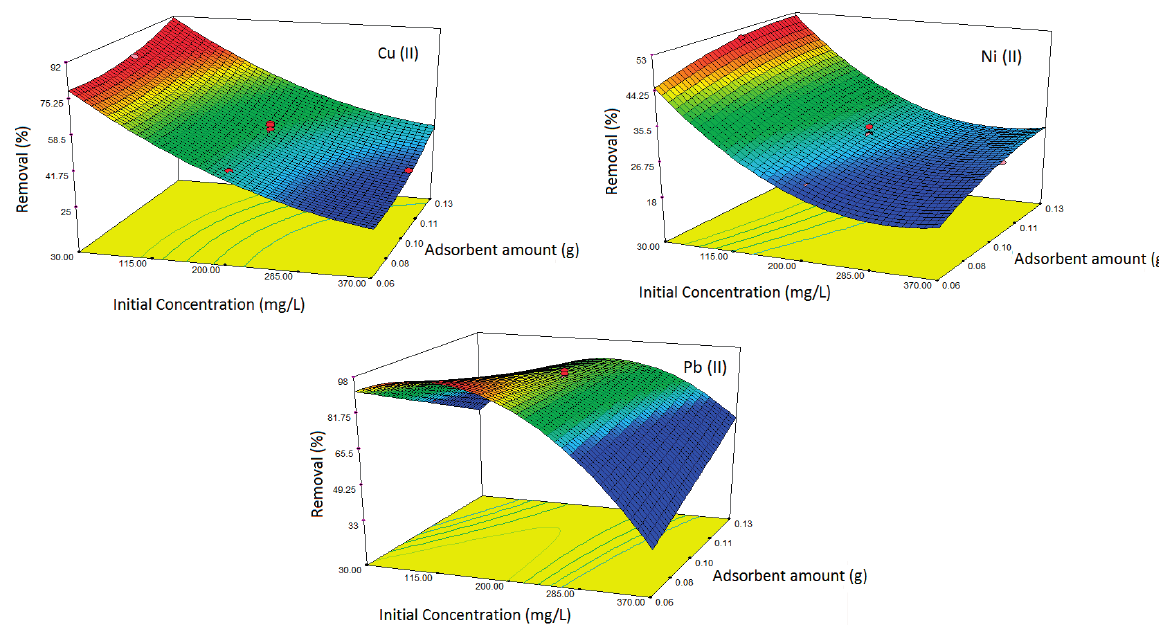
Figure 3. Response surface 3D plots indicating the effect of interaction between heavy metal ion concentration and adsorbent amount for Cu(II), Ni(II) and